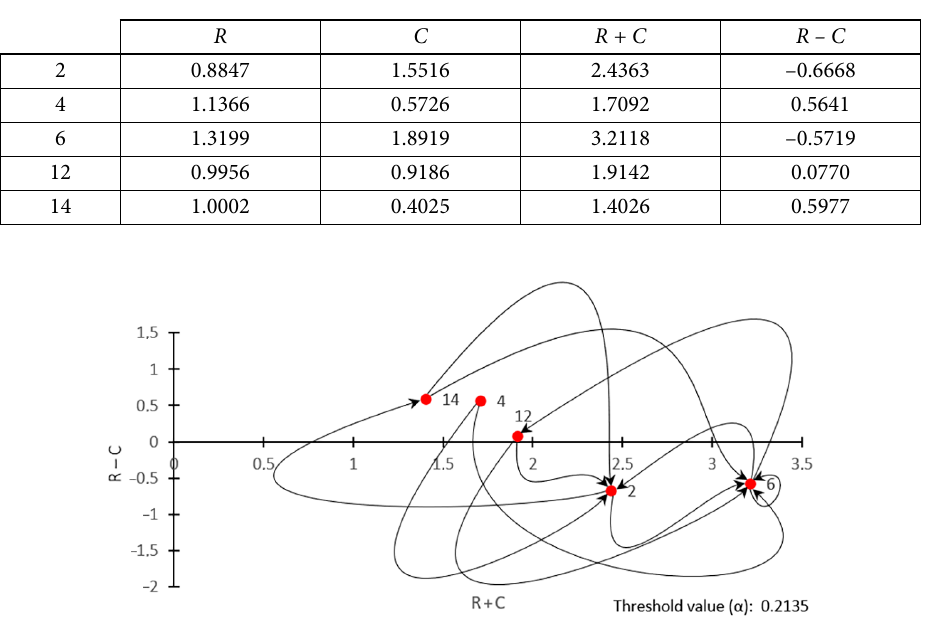
Table 16. Auxiliary calculations for C1 Physical Space